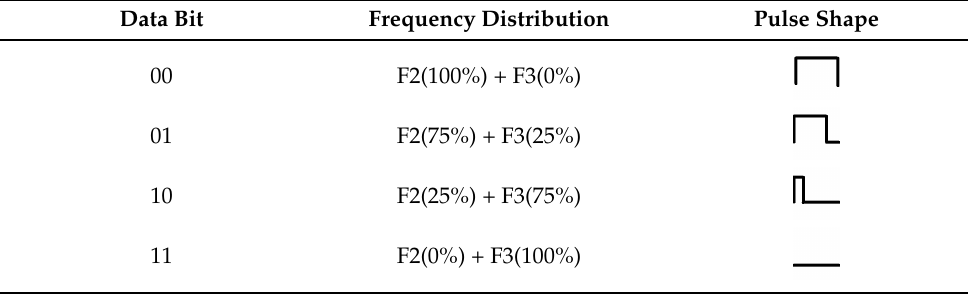
Figure 6. Sample Frame Format in terms of Frequency for HFSPDM. Table 1. HFSPDM Frequency Mapping